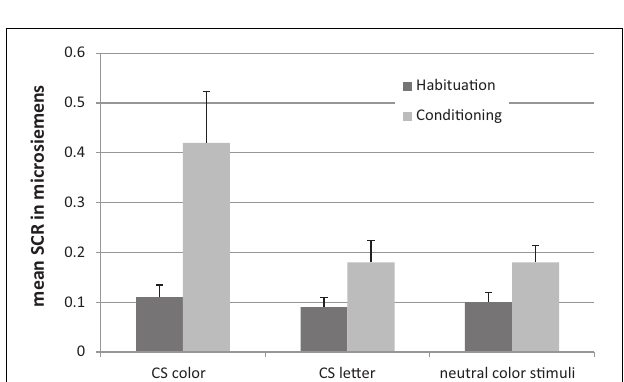
FIGURE 4 | Results from the synaesthetic conditioning paradigm showing a conditioning response for the CS color, but not the CS letter and neutral color stimuli for trained non-synaesthetes. Error bars represent standard errors. Adopted from Meier and Rothen